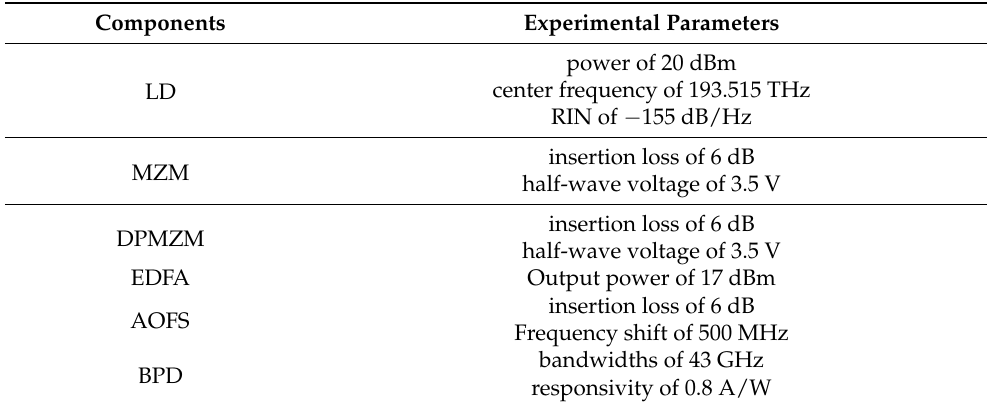
Table 1. The main parameters of the components used in the experiment.